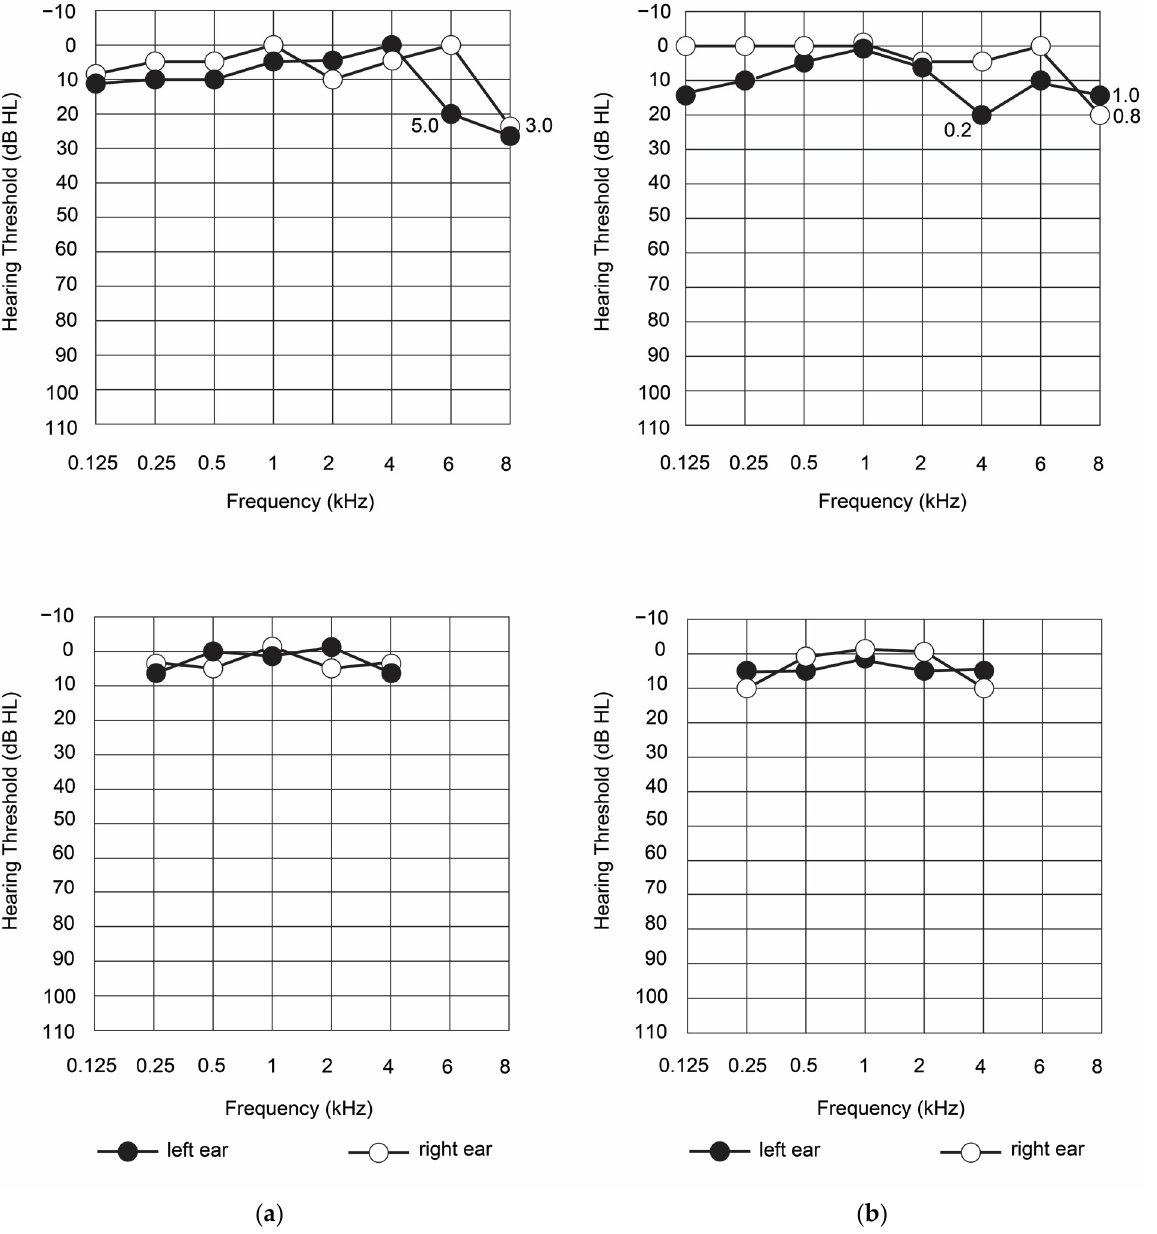
Figure 1. The results of air ( upper panels) and bone ( bottom panels) standard audiometry in the studied patient at the first appointment ( a ) and after 4 months of observation ( b ).